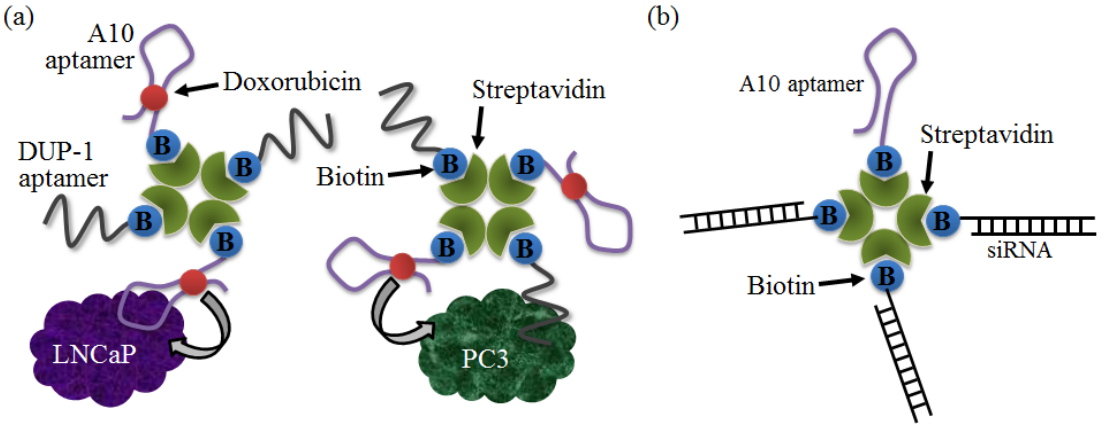
Figure 11. ( a ) A schematic illustration of the active targeting of the drug doxorubicin to prostate cancer cells using the dual-aptamer (A10 and DUP-1) complex. Doxorubicin that is bound to an A10 aptamer can enter both PSMA(+) and PSMA( − ) prostate cancer cells via the dual-aptamer complex; ( b ) Design of an siRNA-aptamer conjugate via a